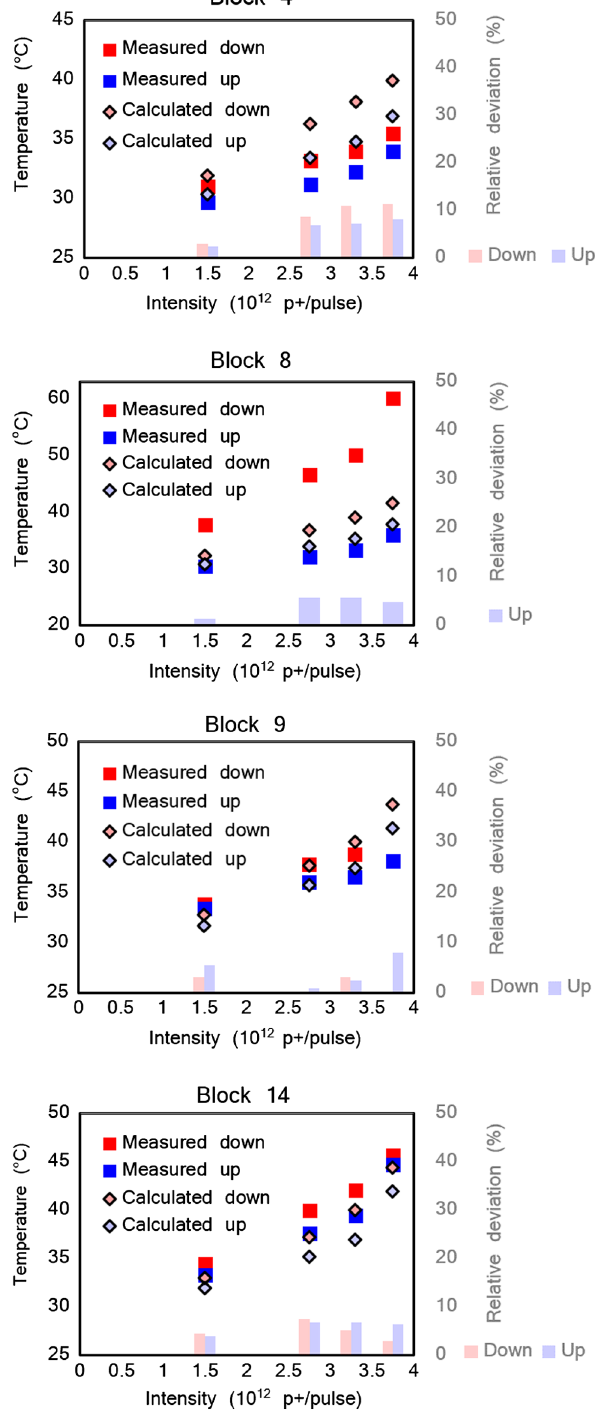
FIG. 15. Maximum temperature measured by the twotemperature sensors (up and down) of the four instrumented target blocks. The plotted values correspond to the average maximum temperature measured at different intensities once steady-state regime was reached: 1.5, 2.75, 3 . 25 × 10 12 ppp (10.8seconds cycle) and 3 . 75 × 10 12 ppp (7.2 seconds cycle). A comparison with the temperatures obtained from the FEM simulations is shown, as well as the relative deviation between both values, calculated as ð T